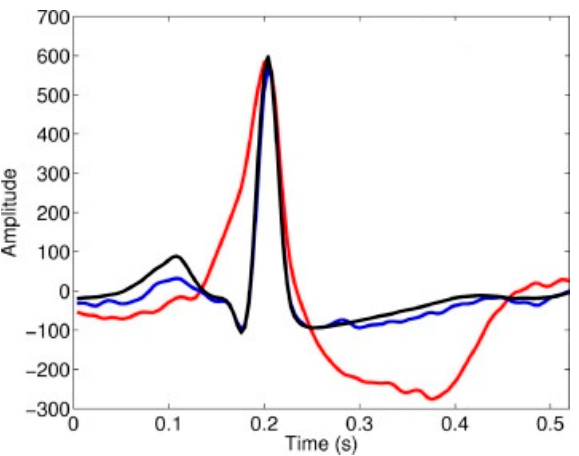
Figure 5. Template matching of segmented heartbeat where red is the original abnormal beat and blue and black is the original normal beat and template beat, respectively.